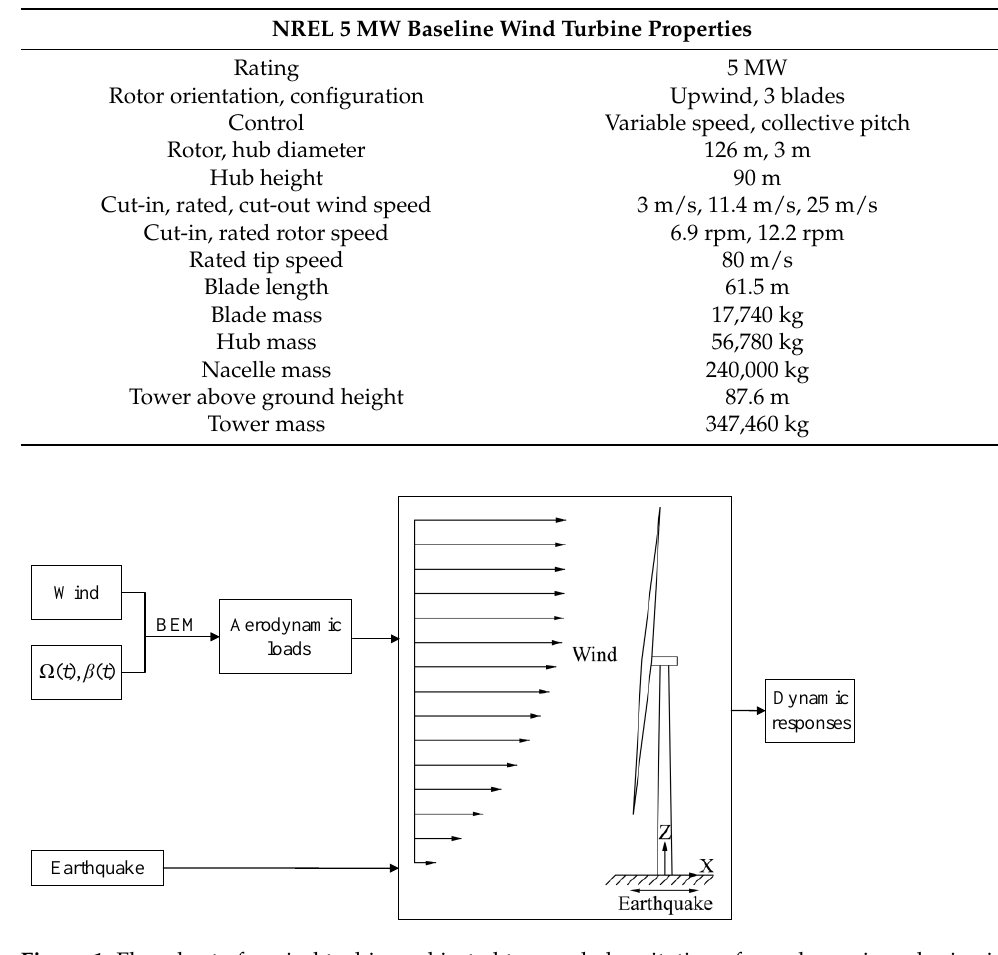
Figure 1. Flowchart of a wind turbine subjected to coupled excitation of aerodynamic and seismic loads.